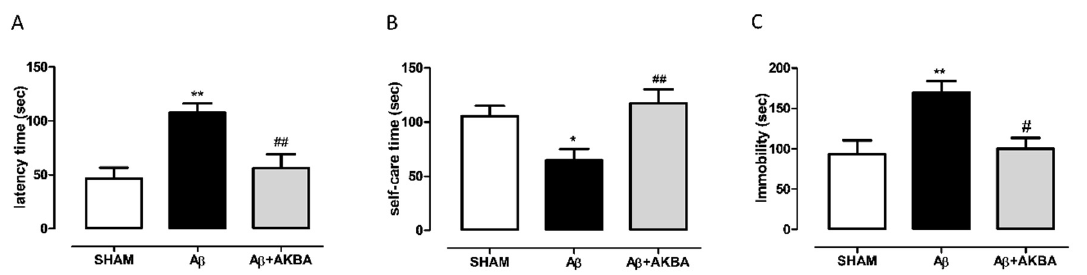
Figure 3. Behavioral effects of AKBA administration in A β -treated mice by using the splash test and the tail suspension test. ( A ) Latency to leak (sec) in the splash test of mice 7 days after icv injection of vehicle (SHAM, 5 µL, white bar), A β (A β , 4 µM, black bar), and A β +AKBA (A β , 4 µM + sublingual AKBA, 5 mg/kg, gray bar), (SHAM n = 9, A β n = 9, A β +AKBA n = 10). ( B ) Time spent performing self-care (sec) in the splash test of mice 7 days after icv injection of vehicle (SHAM, 5 µL, white bar), A β (A β , 4 µM, black bar), and A β +AKBA (A β , 4 µM + sublingual AKBA, 5 mg/kg, gray bar), (SHAM n = 9, A β n = 9, A β +AKBA n = 10). ( C ) Immobility time (sec) in the tail suspension test of mice 7 days after icv injection of vehicle (SHAM, 5 µL, white bar), A β (A β , 4 µM, black bar), and A β +AKBA (A β , 4 µM + sublingual AKBA, 5 mg/kg, gray bar), (SHAM n = 12, A β n = 9, A β +AKBA n = 6). One-way ANOVA followed by Tukey’s multiple comparisons test, ** p < 0.01, * p < 0.05 A β versus SHAM, and ## p < 0.01, # p < 0.05 A β +AKBA versus A β .